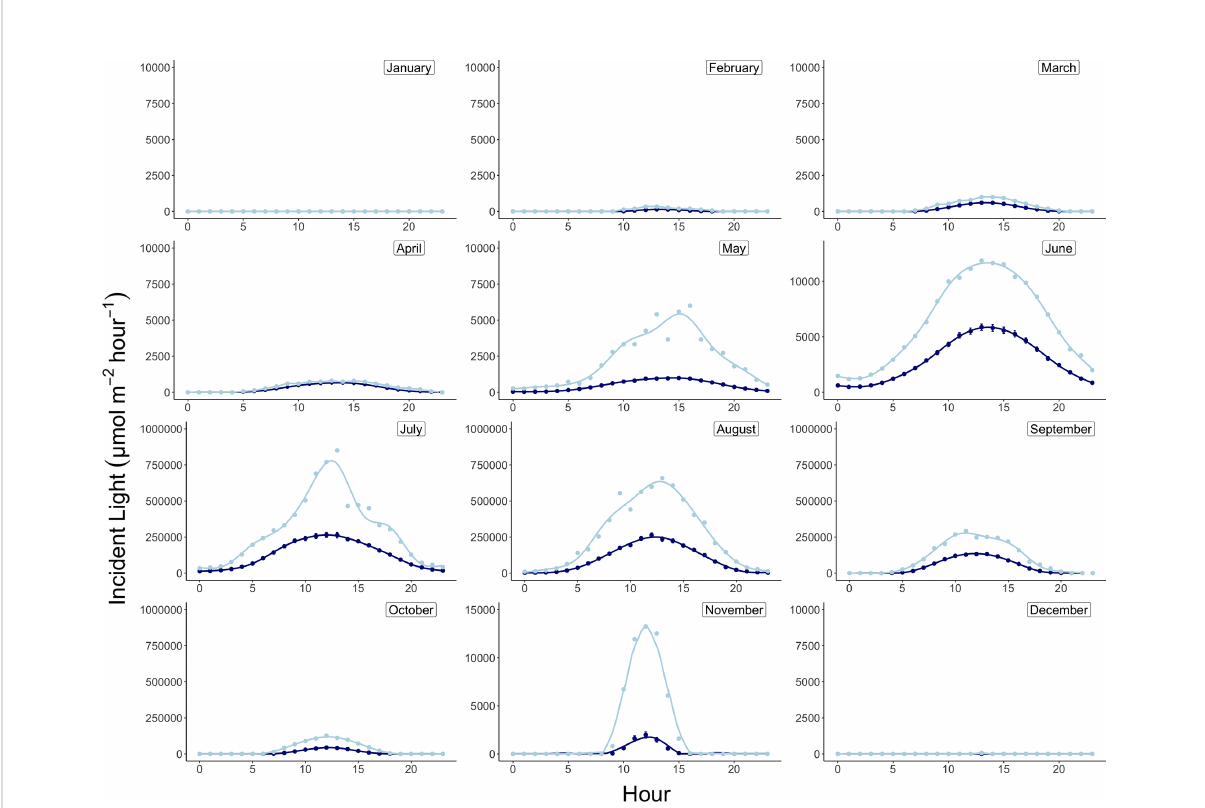
FIGURE 3 Daily average (navy) and maximum (light blue) incident light pro fi les by month at 15m depth in Arctic Bay, Nunavut, Canada across the experimental period. Note differences in y-axis scales.